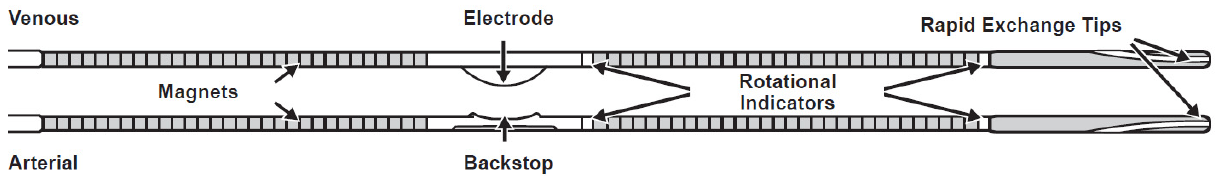
Figure 1. WavelinQ TM EndoAVF Generator with Arterial and Venous Catheters.